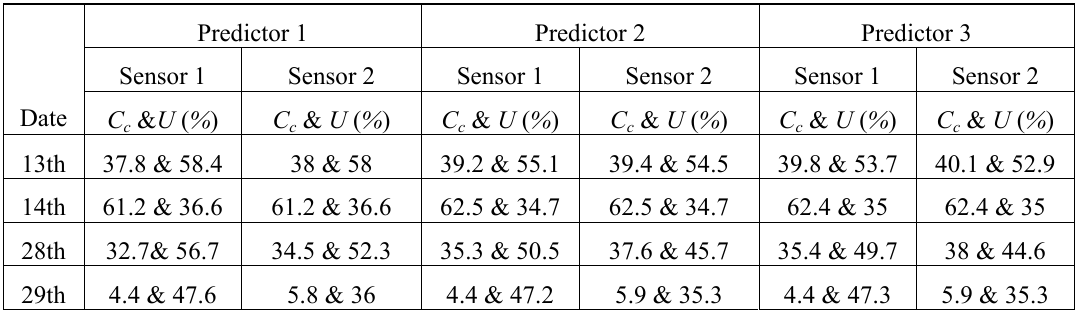
Table 2. Correct rate of cloud prediction ( C with different predictors.